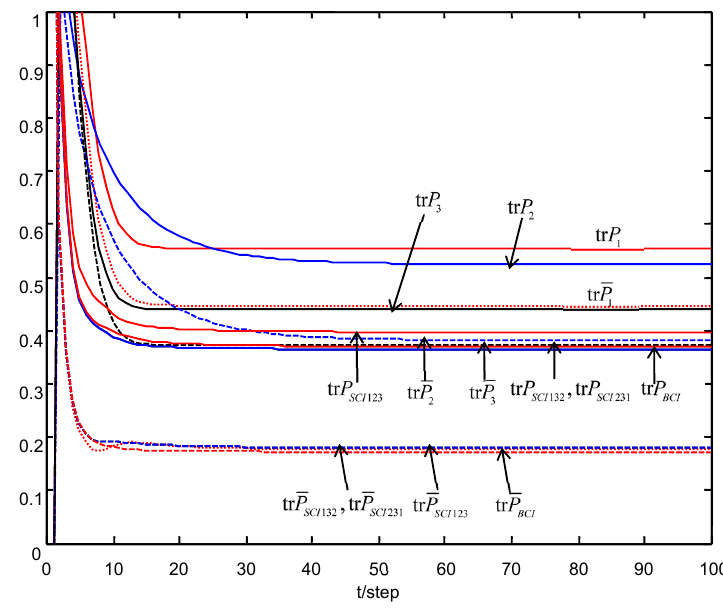
Figure 3. The robust accuracy relations of the local and fused robust Kalman filters. Figure 3. the robust accuracy relations of the local and fused robust Kalman filters. Table 4. The robust accuracy comparison of local and fused steady-state Kalman